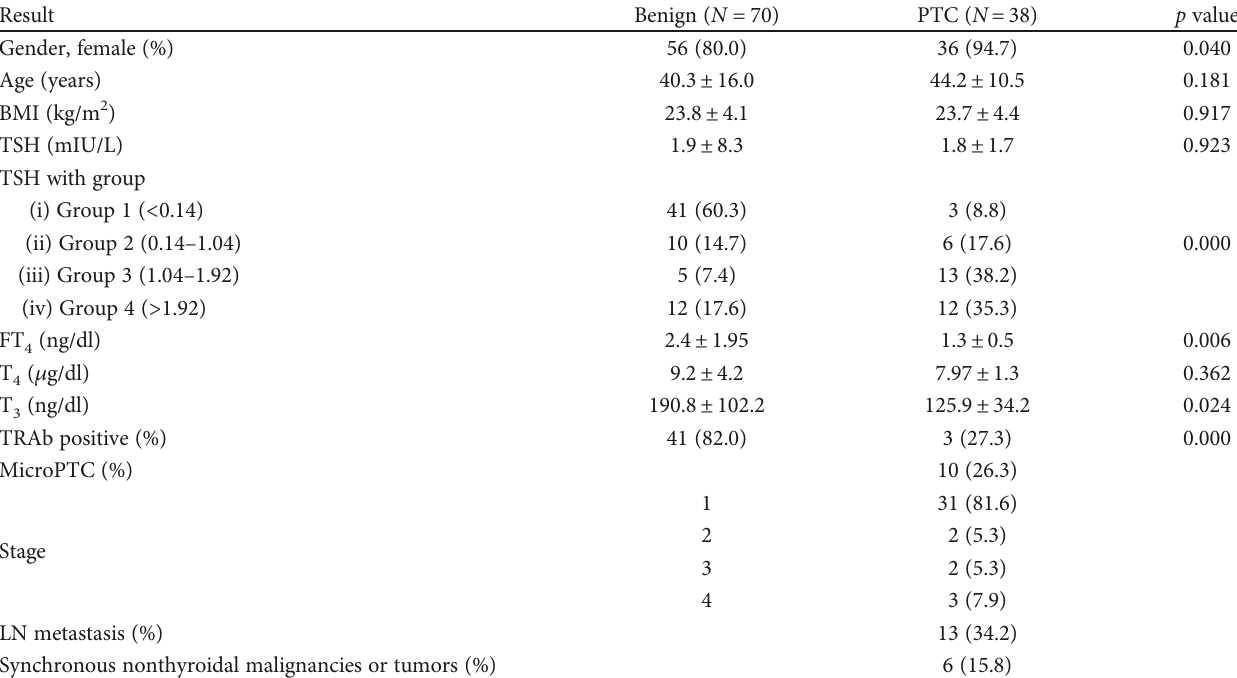
Table 5: Subgroup analysis of patients with coexisting Hashimoto ’ s